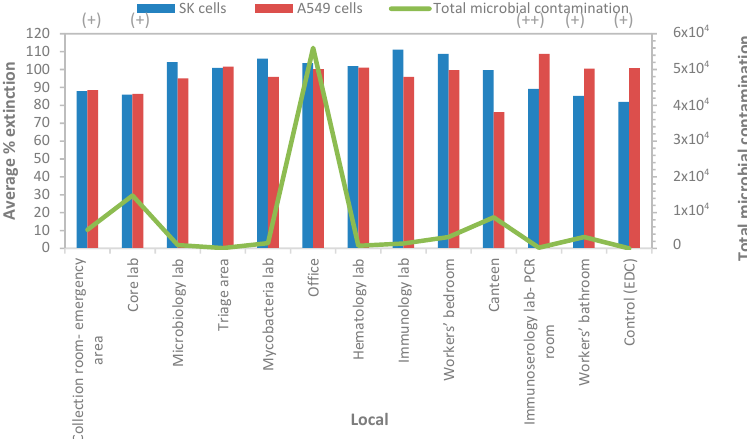
Figure 2. Cumulative microbial contamination (TSA, VRBA, MEA, and DG18) and cell viability (average percentage of extinction, MTT assay) in EDC samples. ( + ), low cytotoxic e ff ect; ( ++ ), medium cytotoxic e ff